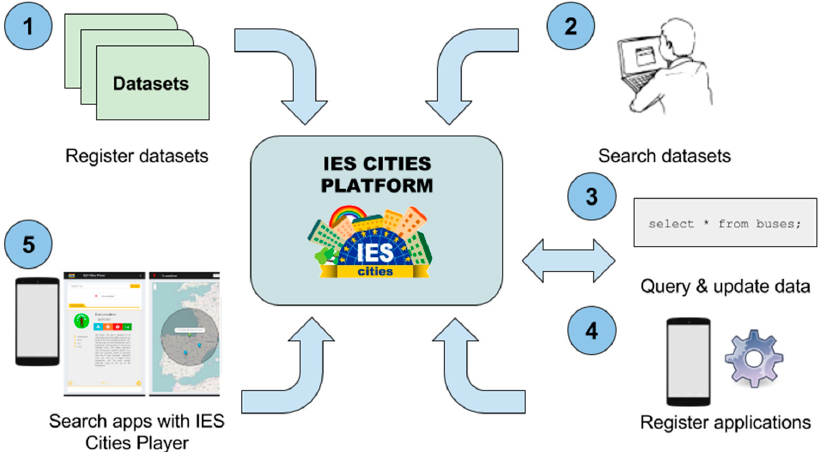
Figure 3. Main operation of the IES Cities’ platform showing: (1) registration of datasets; (2) search of datasets; (3) data query using SQL; (4) application registration; (5) app discovery through IES Cities Player. Cities